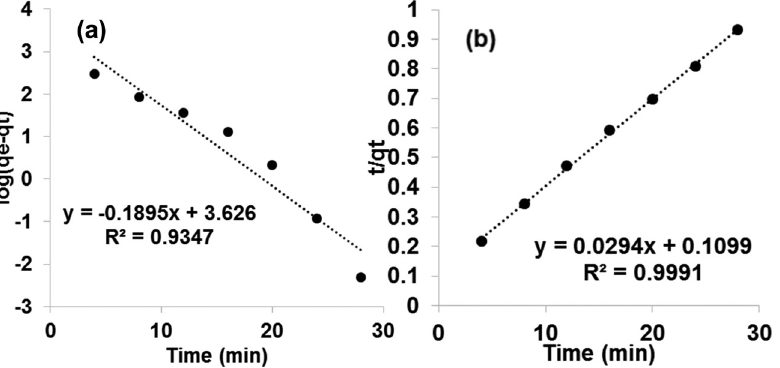
Figure 5: ( a ) Pseudo - fi rst - order - and ( b ) pseudo - second - order kinetics for the uptake of MO by